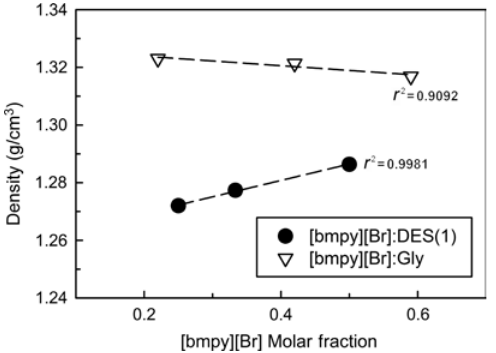
Figure 5: Viscosity in logarithm form versus temperature plots of (A) BDES and (B) TDES. The data points are viscosity data obtained from experiment (error bars are smaller than data points), and the solid lines are fittings of the data to Arrhenius model.